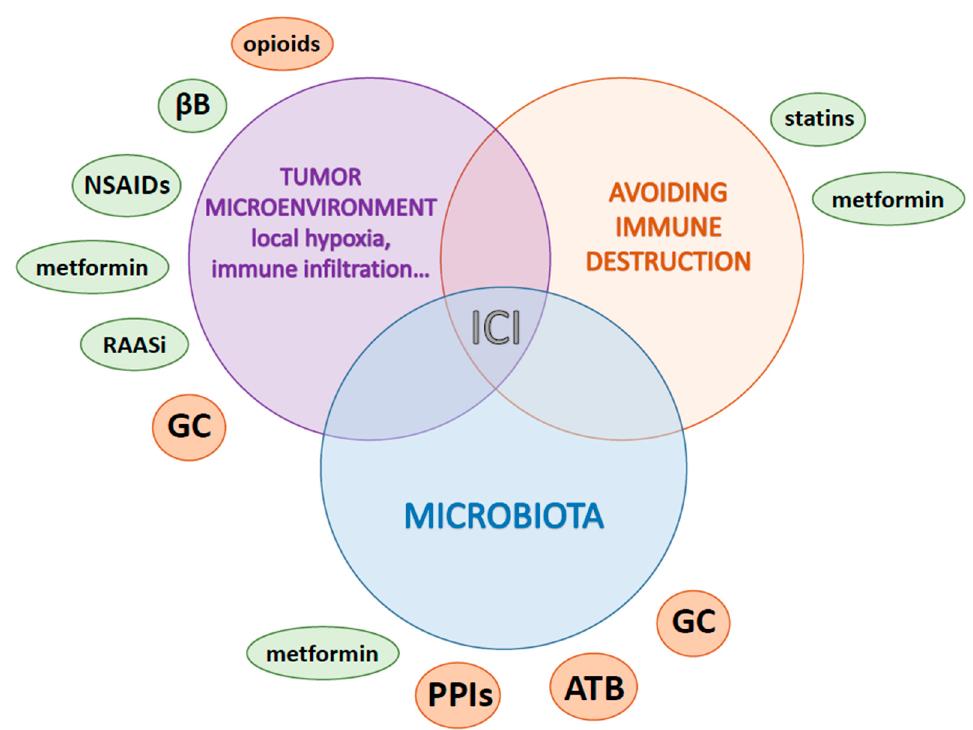
Figure 2. Multiple interactions between drugs, cancer hallmarks and ICI efficacy (red/green: nega- tive/positive impact on ICI efficacy, respectively; ICI: immune checkpoint inhibitor; GC: glucocor- ticoids; ATB: antibiotics; PPIs: proton pump inhibitors; NSAIDs: non-steroidal anti-inflammatory drugs and aspirin; ꞵ B: beta blockers; RAASi: renin-angiotensin-aldosterone system inhibitors).